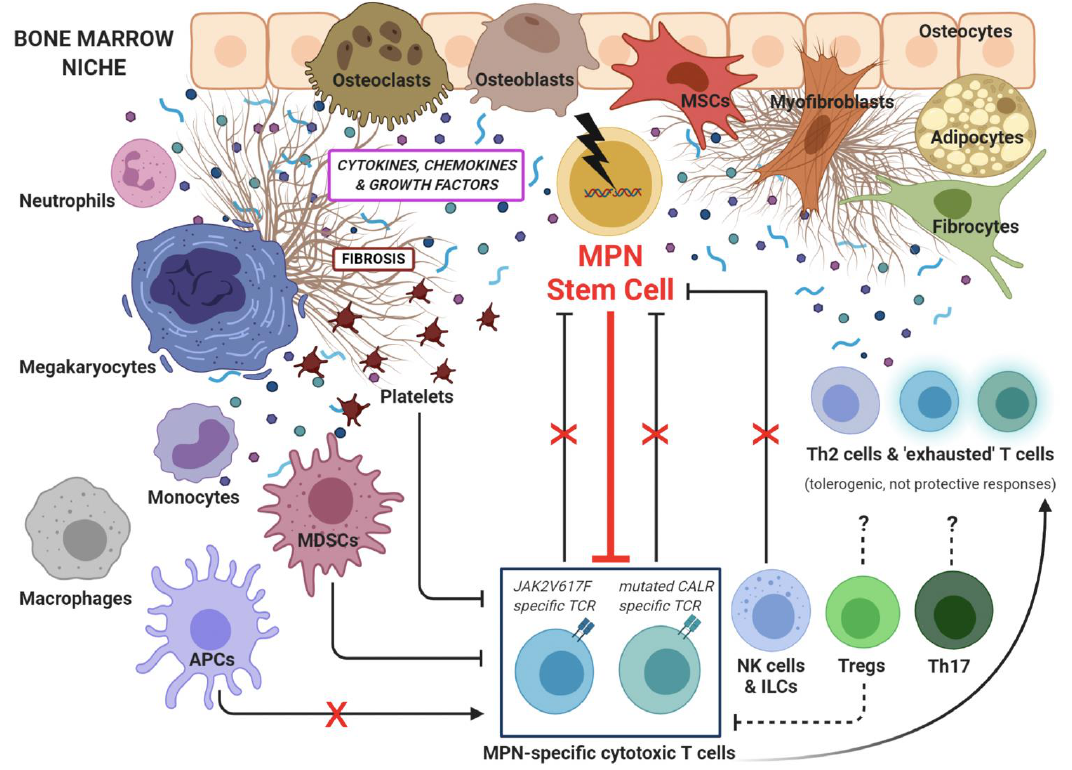
Figure 1. The emerging cancer ecosystem in myeloproliferative neoplasms (MPNs). Several cellular players contribute to the MPN-associated microenvironment, characterized by increased cytokine signaling, fibrosis, inflammation-driven immunosuppression and immune escape. MSCs: mesenchymal stem cells, MDSCs: myeloid-derived suppressor cells, APCs: antigen-presenting cells, TCR: T cell receptor, Th: T helper, NK: natural killer, ILCs: innate lymphoid cells, Tregs: T regulatory cells, ⊥ : inhibition, X: